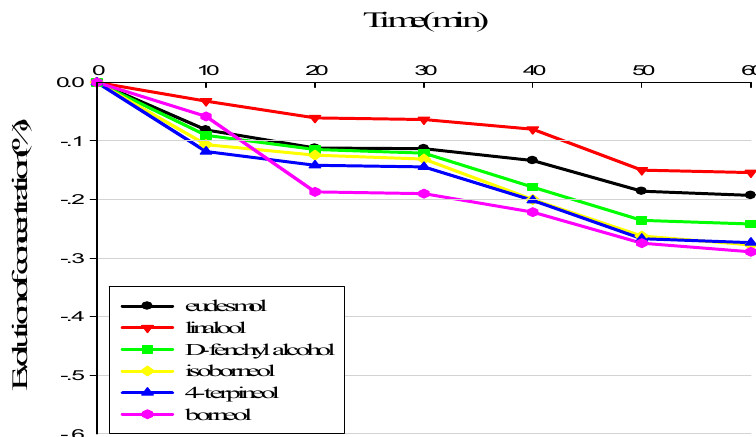
Figure 2. Volatie loss of terpene alcohols over time in sensory analysis in Terpenes Recombination.